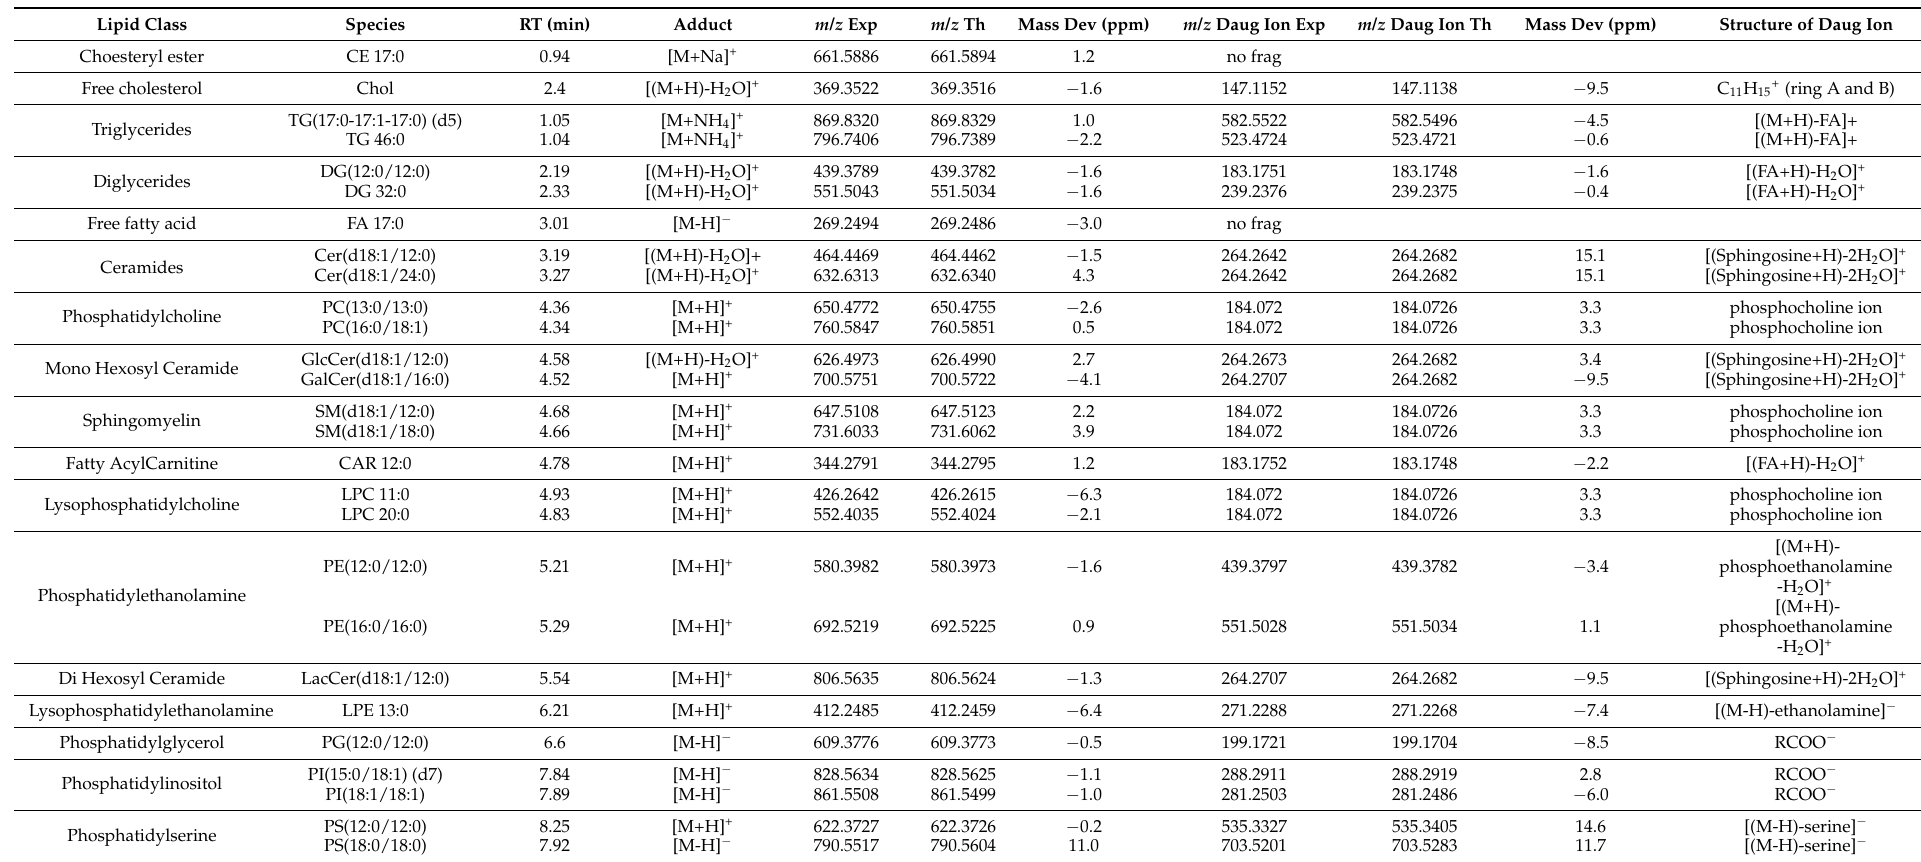
Table 1. Chromatographic and mass spectrometry characterisation with theorical (Th) and experimental (Exp) masses with the m / z of daughter (daug) ion and their retention time (RT) for internal standard and few molecular